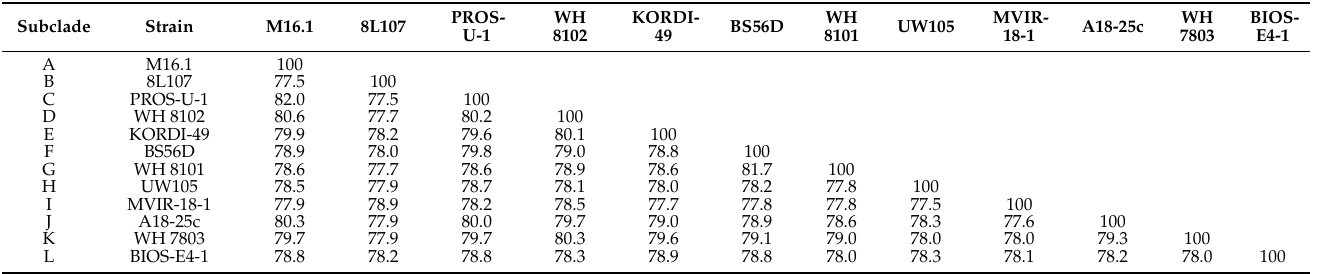
2.2. Number, Relative Abundance (RA), and Relative Density (RD) of SSRs and CSSRs